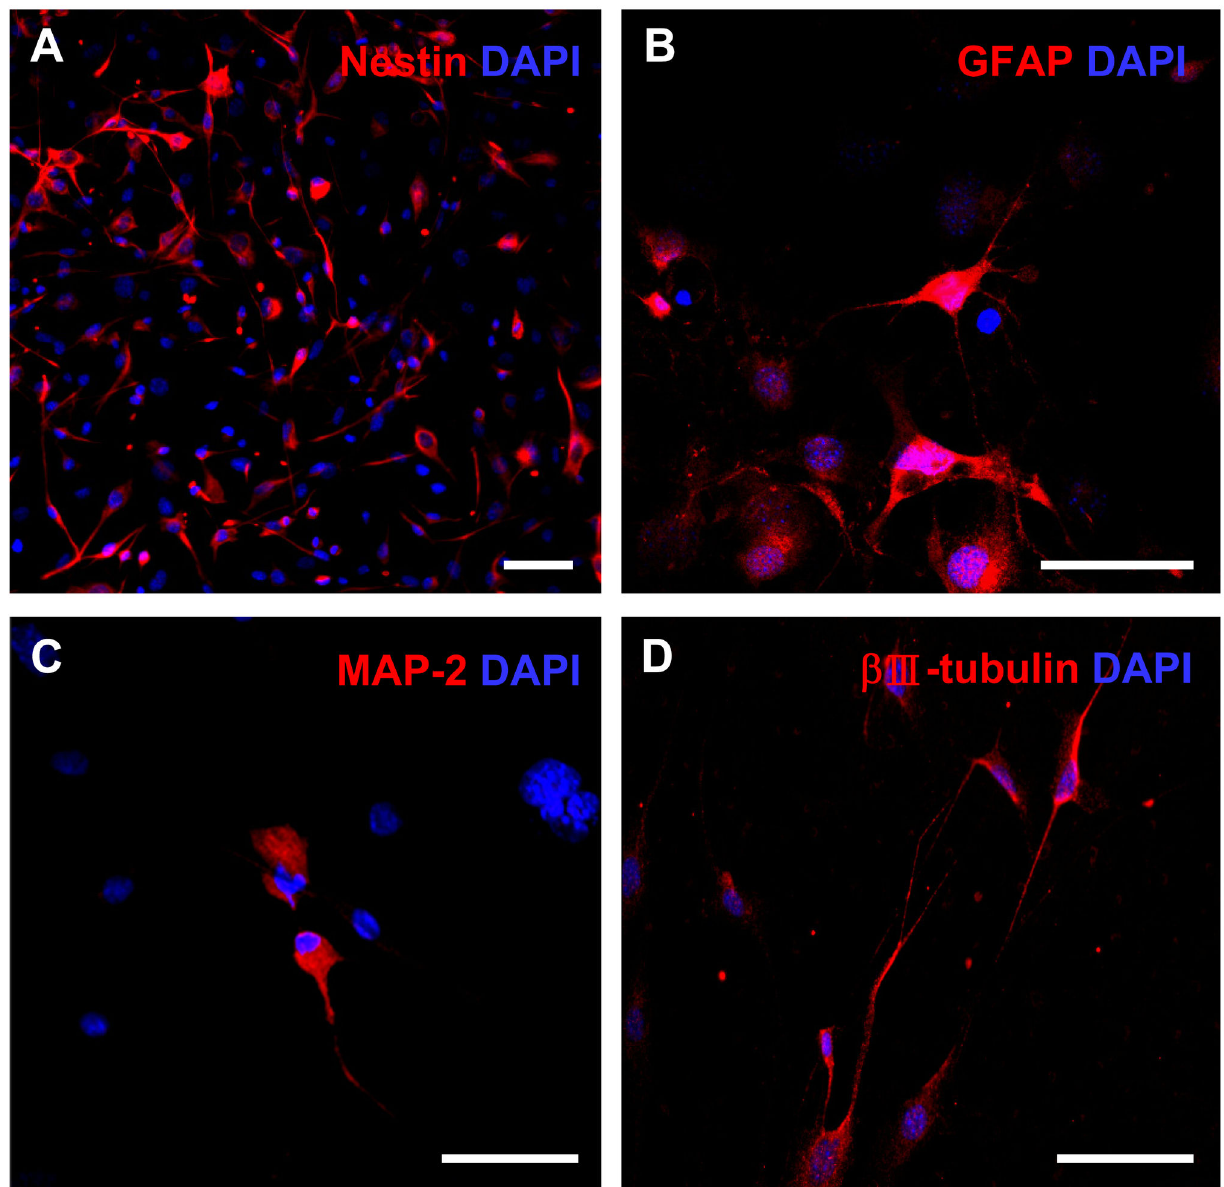
Figure 4. Neuroectodermal differentiation potential of mUC-MSCs. Cells of passage number 12–20 were induced to form neural cells by culturing in induction medium for 7 days. Cells were co-stained with DAPI and neural progenitor marker, nestin, at 6 hr (A); or astroglial marker, GFAP (B); and neuronal markers, including MAP 2 (C) and β Ⅲ -tubulin (D), at 5 days post-induction. Scale bar = 50 µm.